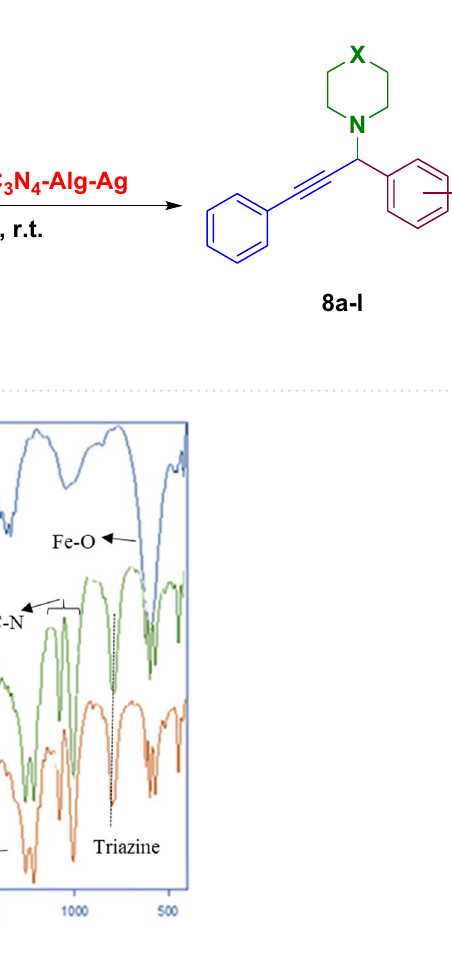
Figure 4. FT-IR spectra of ( a ) Fe 3 O 4 , ( b ) g-C 3 N 4 and ( c ) Fe 3 O 4 -g-C 3 N 4 -Alg-Ag